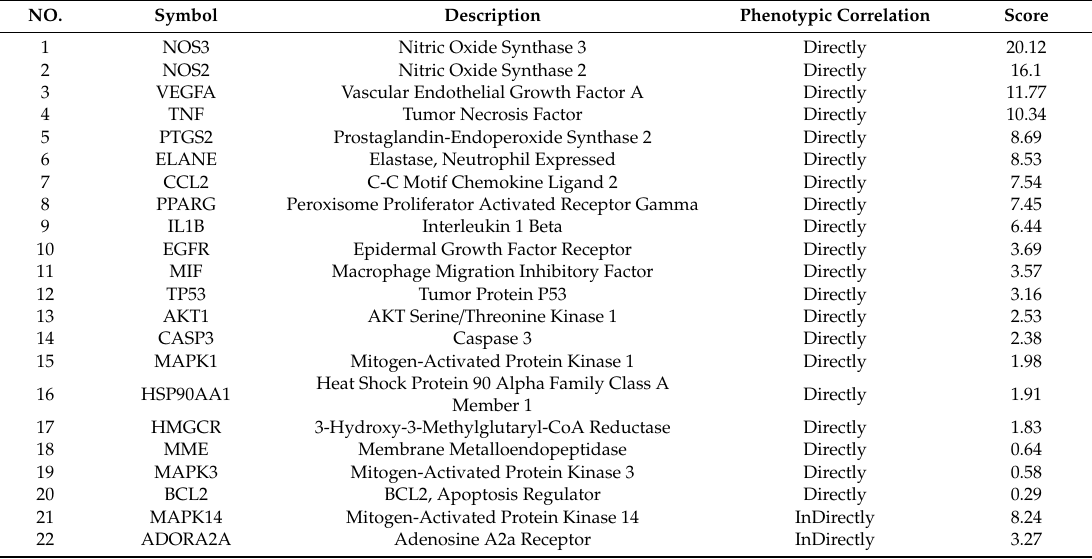
Table 2. VarElect analysis of targets of genistein with the “pulmonary hypertension” phenotype.